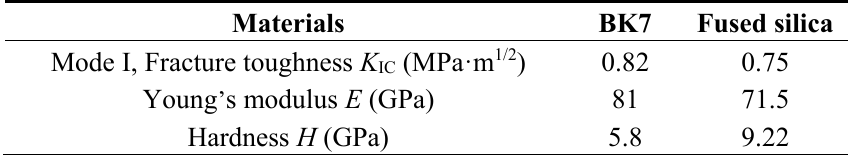
Table 1. Mechanical properties of boroscilate crown glass (BK7) and fused silica [16–18].